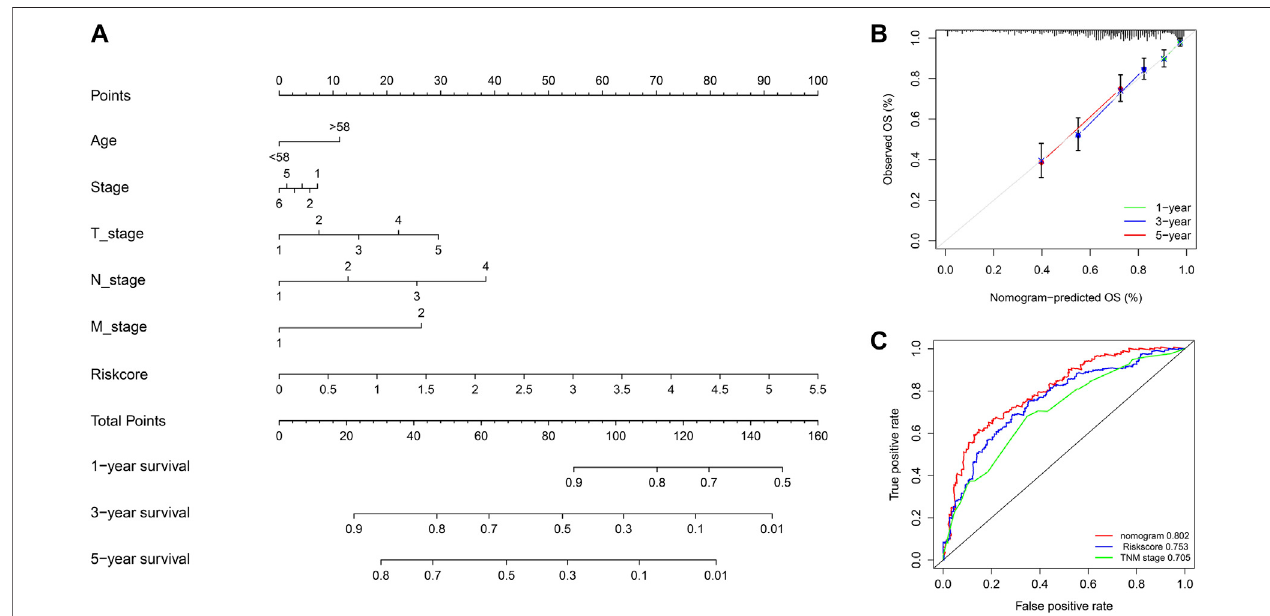
FIGURE6| Nomogrammodelforpredictingtheoverallsurvivalofmelanomapatients. (A) Nomogramforpredicting1-,3-,and5-yearoverallsurvivalformelanoma patients in TCGA cohort. (B) Calibration curves of nomograms in terms of the agreement between predicted and observed 1, 3, and 5 years of outcomes in TCGA cohort. (C) Time-dependent ROC curves comparing prognostic accuracy of risk score, TNM stage, and the nomogram model in TCGA SKCM patients.